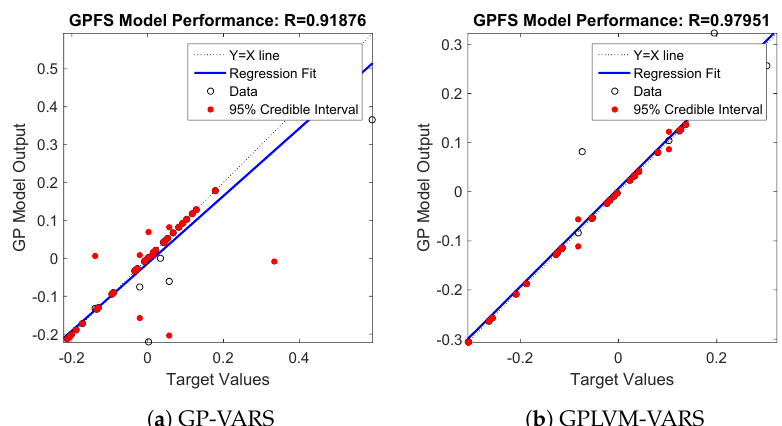
Figure 4. The comparison of model performance in the synthetic data with the left ( a ) and right ( b ) figures corresponding to regression results from GP-VARS and the proposed GPLVM-VARS,